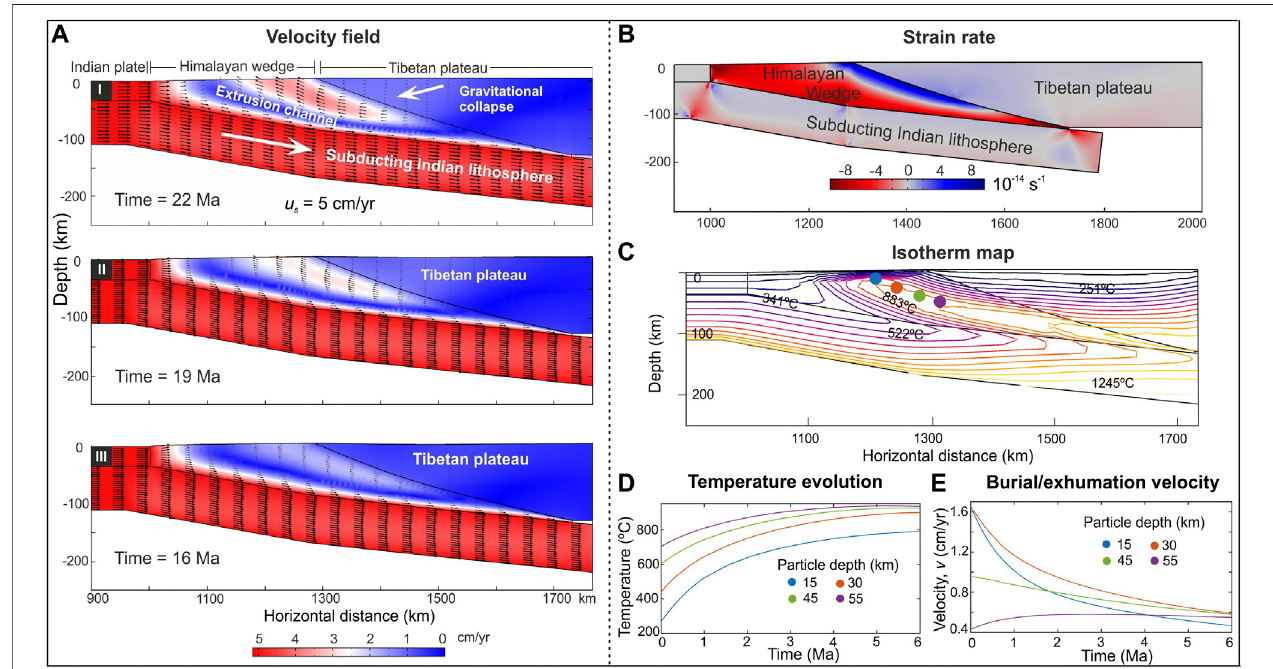
FIGURE 5 | (A) Calculated plots of the magnitudes of velocity vectors, obtained from numerical simulations with u s (cid:1) 5 cm/yr. (B) Graphical plots of the horizontal strain rates ( _ ε xx ) for u s (cid:1) 5 cm/yr. In the strain-rate maps the color bar indicates positive values for extension and negative values for contraction. (C) Isotherm map after 4 Ma of model run with u s (cid:1) 5 cm/yr. Note the spectacular inversion of the isotherms within the wedge shown in panel (B) due to heat advection through the extrusion zone. (D, E) Temporal variations of temperature and burial/subduction velocity at some selected points (locations shown in panel (C) ) in the wedge.